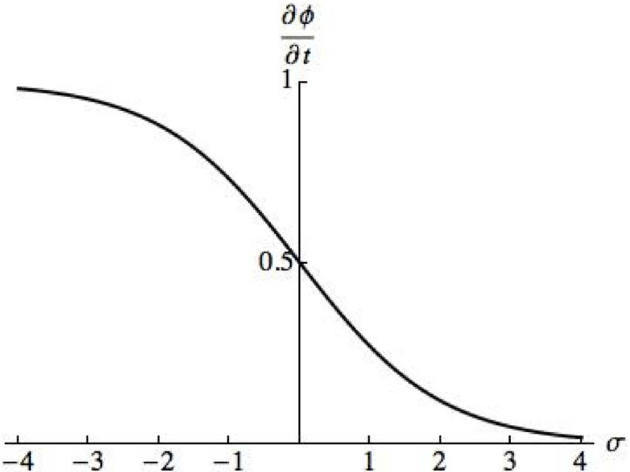
(cid:0) (cid:1) (cid:0) (cid:1)(cid:2) (cid:3) ¼ C m (cid:0) (cid:15) b D G þ b s (cid:0) 1 Fig 2. Graph of @(cid:30) tanh b . In [15], specific parameter values are not provided 1 b @ t 2 2 2 and a dimensionless system of equationsis solved. In the graph we use parameter values C 1 = 1, μ b = 0, (cid:15) b = s , whereasin Eq (8) the term b 1, β = 1, and Δ G = 0. Note that in the function graphedwe add b 2 This is becausecompressive stresses, which are assumed in [15] to activate FA formation, are negative,and f a is denotedto be a positive force